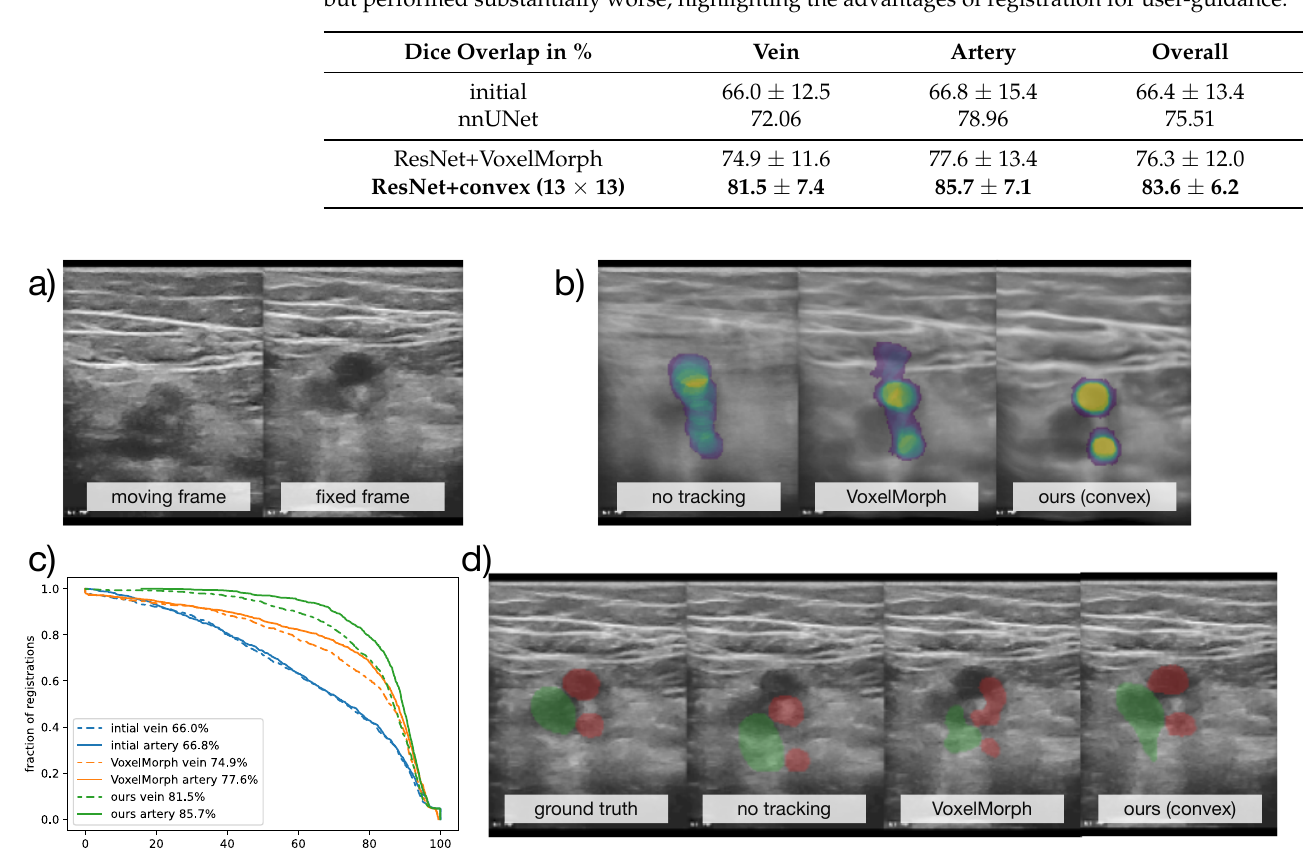
Figure 6. Qualitative results for the CoCoAI dataset. ( a ) shows two original frames from a compres- sion sequence, ( b ) across all registrations with the same fixed frame the label probabilities for arteries after registration were averaged, and, ideally, two non-blurry circles should be seen, ( c ) the cumula- tive accuracy plot for all compared methods shows the advantage of our approach, ( d ) an example segmentation propagation (vein in green, arteries in red), shows that VoxelMorph’s deformation was not as plausible as